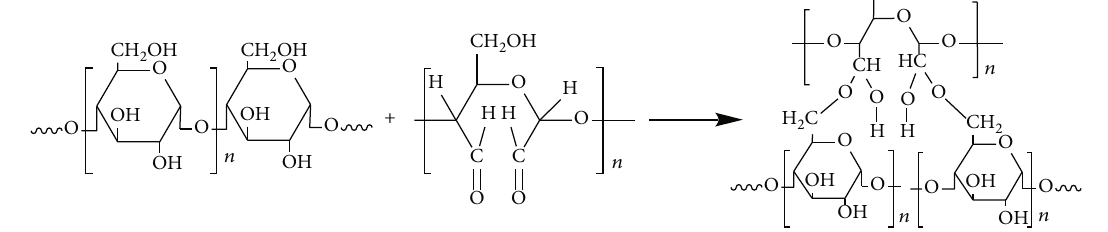
Figure 1: Schematics of cross-linking reaction between OWPF and TPS. Table 1: The aldehyde contents of OWPF prepared at the di ff erent ratios of m(NaIO Sample no.